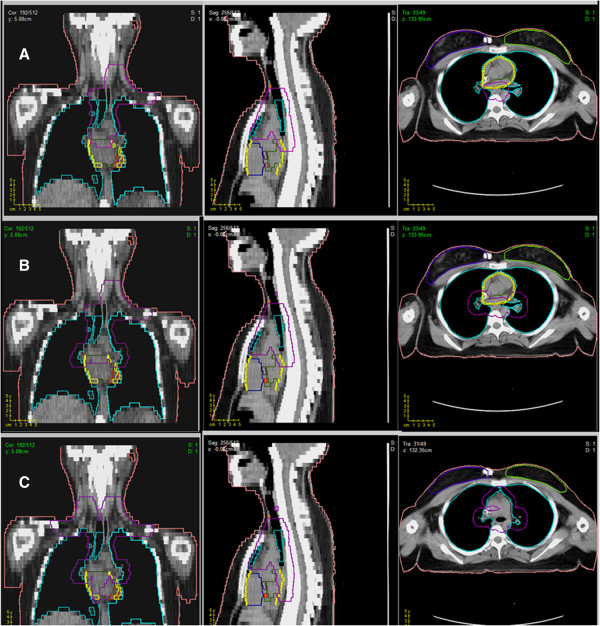
Three different planning target volume size scenarios: A) small (PTV1), B) medium (PTV2), C) large (PTV3). PTVi are outlined in purple.